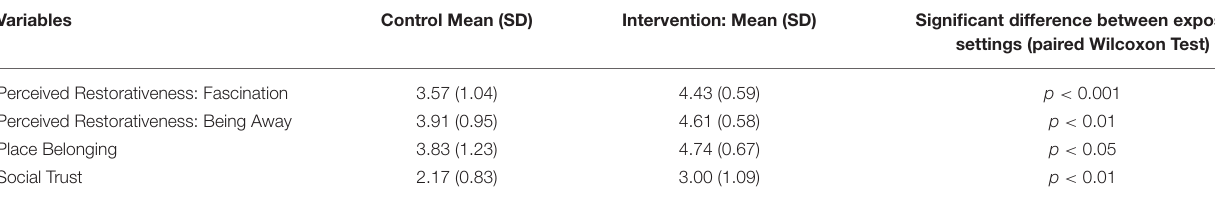
TABLE 2 | Change in subjective well-being to environmental exposure setting, n = 23. Mood variable Control Intervention Repeated measures ANOVA result Pre-walk (mean/SD) Change pre-post (mean/SD) Pre-walk (Mean/SD) Change pre- post (mean/SD)